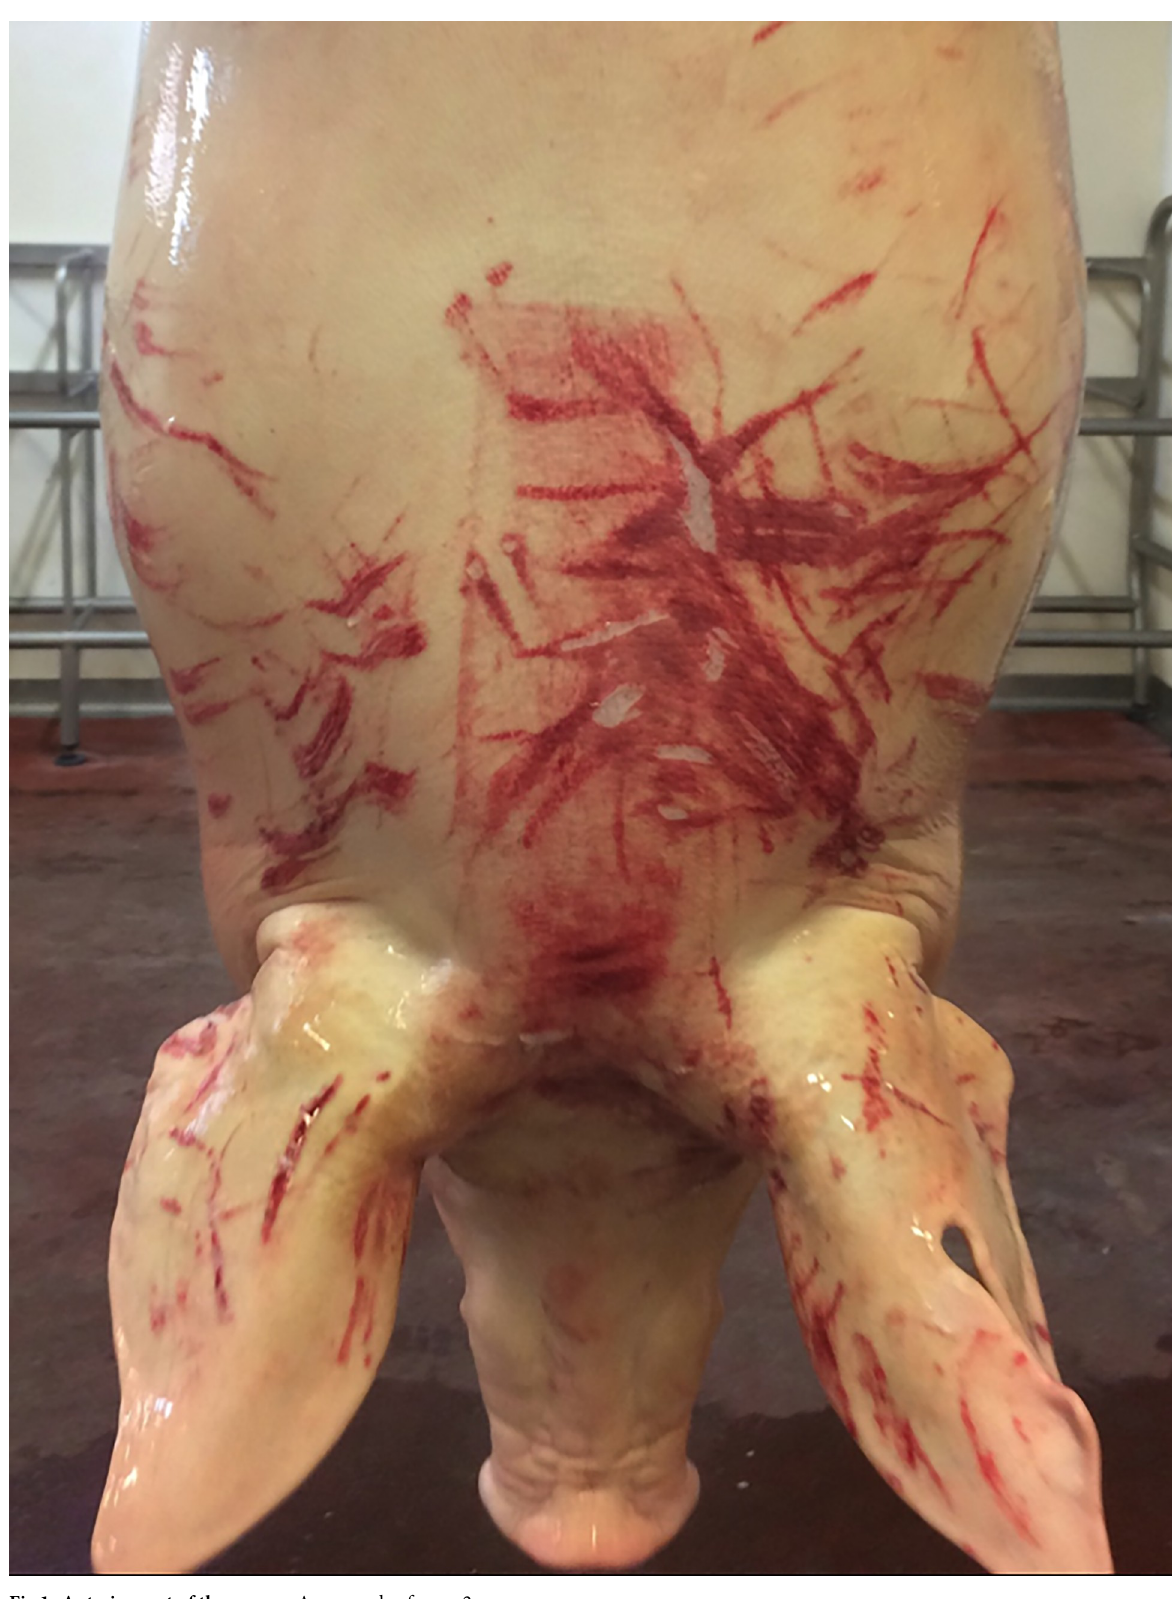
Fig 1. Anterior part of the carcass. An example of score 2. https://doi.org/10.1371/journal.pone.0207115.g001 PLOS ONE | https://doi.org/10.1371/journal.pone.0207115 November12,